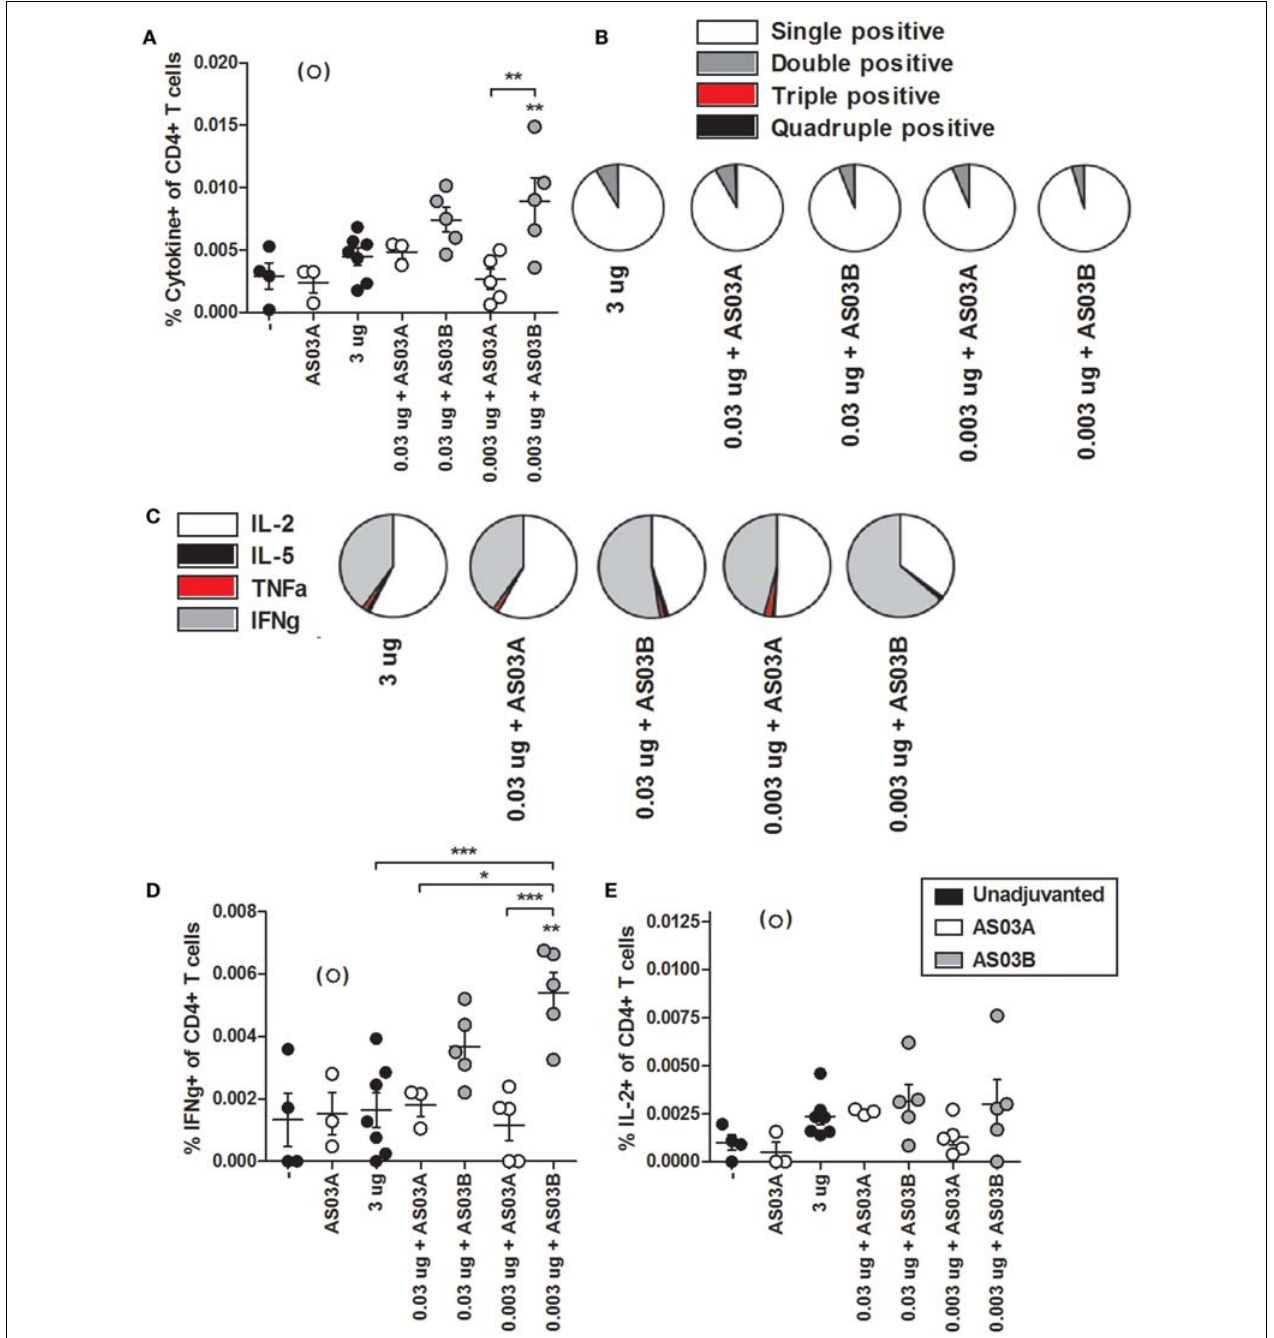
FIGURE 5 | Influenza-specific cytokine-producing CD4 + T cells in splenocytes after two immunizations of unadjuvanted A/Uruguay/716/2007 H3N2 split vaccine or AS03-adjuvanted dose-sparing vaccines . BALB/c mice were immunized intramuscularly on days 0 and 21, and splenocytes were isolated from individual mice on day 42. Splenocytes were stimulated ex vivo with A/Uruguay H3N2 split vaccine and co-stimulatory antibodies, then analyzed by flow cytometry for CD4 + T cells that produced a combination of IL-2, IL-5, IFN γ , or TNF α cytokines. The gating strategy is described in Figure S2 in Supplementary Material and representative dot plots are shown in Figure S3 in Supplementary Material. The percentage of total responding CD4 + T cells